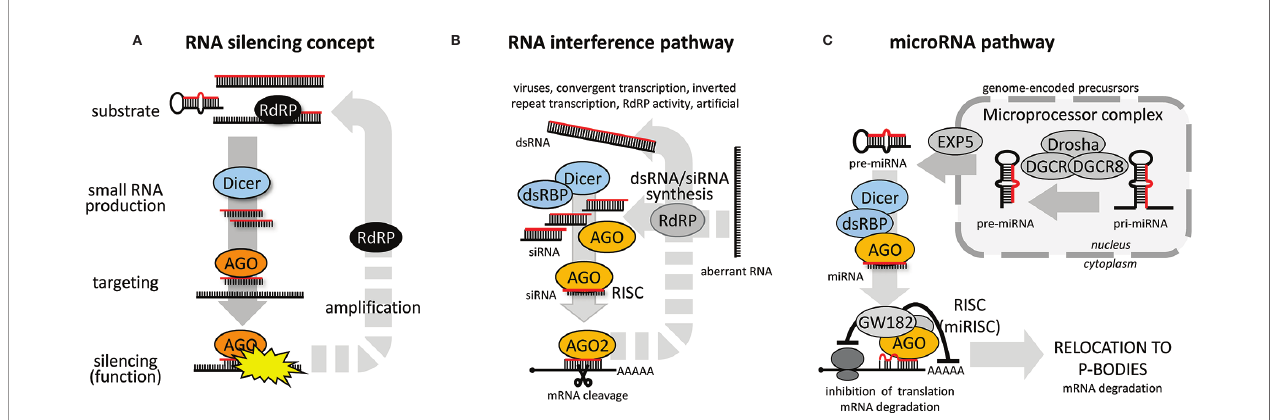
FIGURE 1 | RNA silencing pathways. (A) General concept of RNA silencing. (B) General RNAi pathway overview, and (C) miRNA pathway (animal set